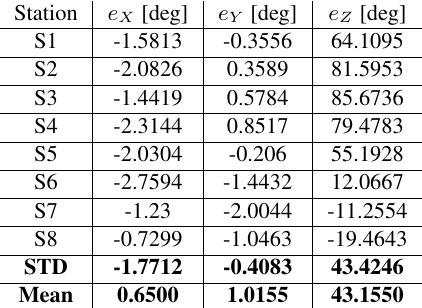
Table 2. Eccentricities adjusted values obtained for AHRS